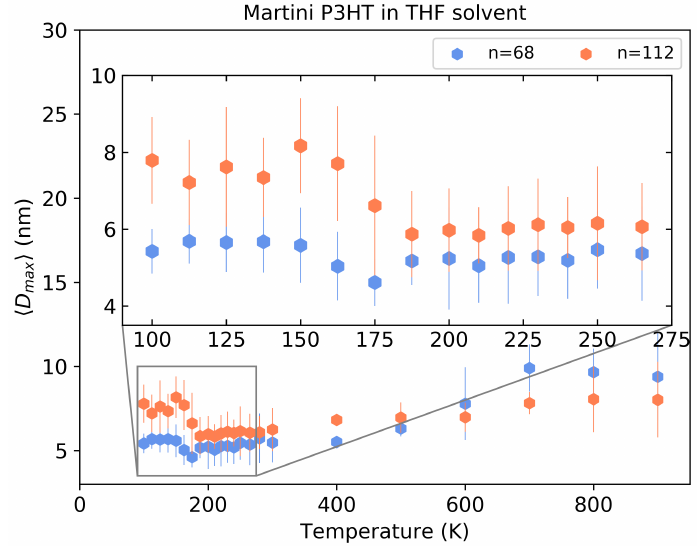
Figure 12. The maximum distance between monomers for the Martini model of P3HT with n = 68 and n = 112 in THF solvent.